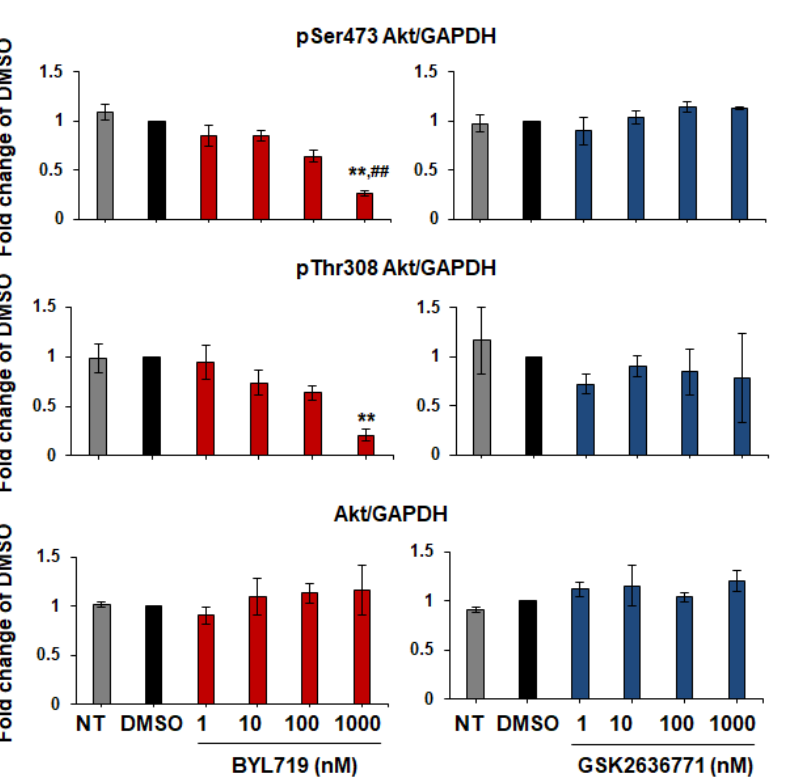
Figure 14. BYL719 inhibits Akt phosphorylation in T11 cells in a dose-dependent manner. T11 cells were treated for 1 h with increasing concentrations of BYL719 and GSK2636771 in complete medium supplemented with 10% FBS. Control cells were left untreated (NT) or treated with DMSO. Phosphorylation and total levels of Akt were analyzed by Western blotting, with GAPDH used as loading control. Signals were visualized using Chemidoc™ MP Imaging System. Graphs show results from densitometry analysis of phosphorylated or total Akt normalized to loading control and expressed as fold change of results from DMSO-treated cells. Data are means ± SEM from the following numbers of independent experiments: pSer473 Akt, n = 3 (apart from GSK2636771 1 µ M, n = 2); pThr308 Akt, n = 3 (apart from NT in BYL719 graph and GSK2636771 1 µ M, n = 2); Akt, n = 3 (apart from NT in BYL719 graph and GSK2636771 100 nM and 1 µ M, n = 2); ** p < 0.01 vs. DMSO; ## p < 0.01 vs. NT.